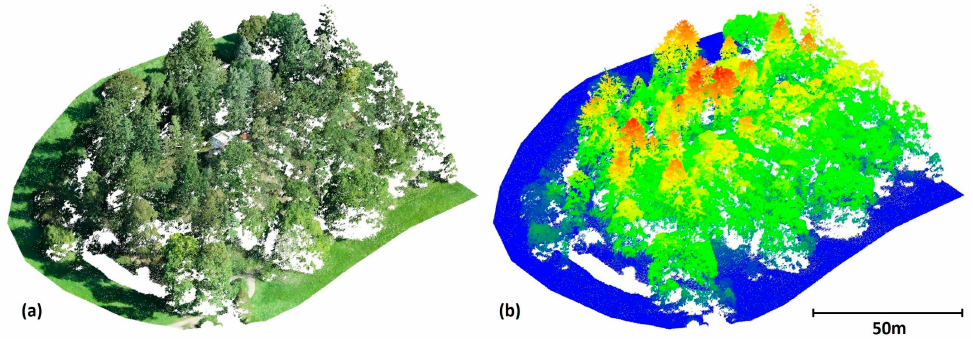
Figure 2. Illustration dataset: ( a ) true colors and ( b ) elevation-coded